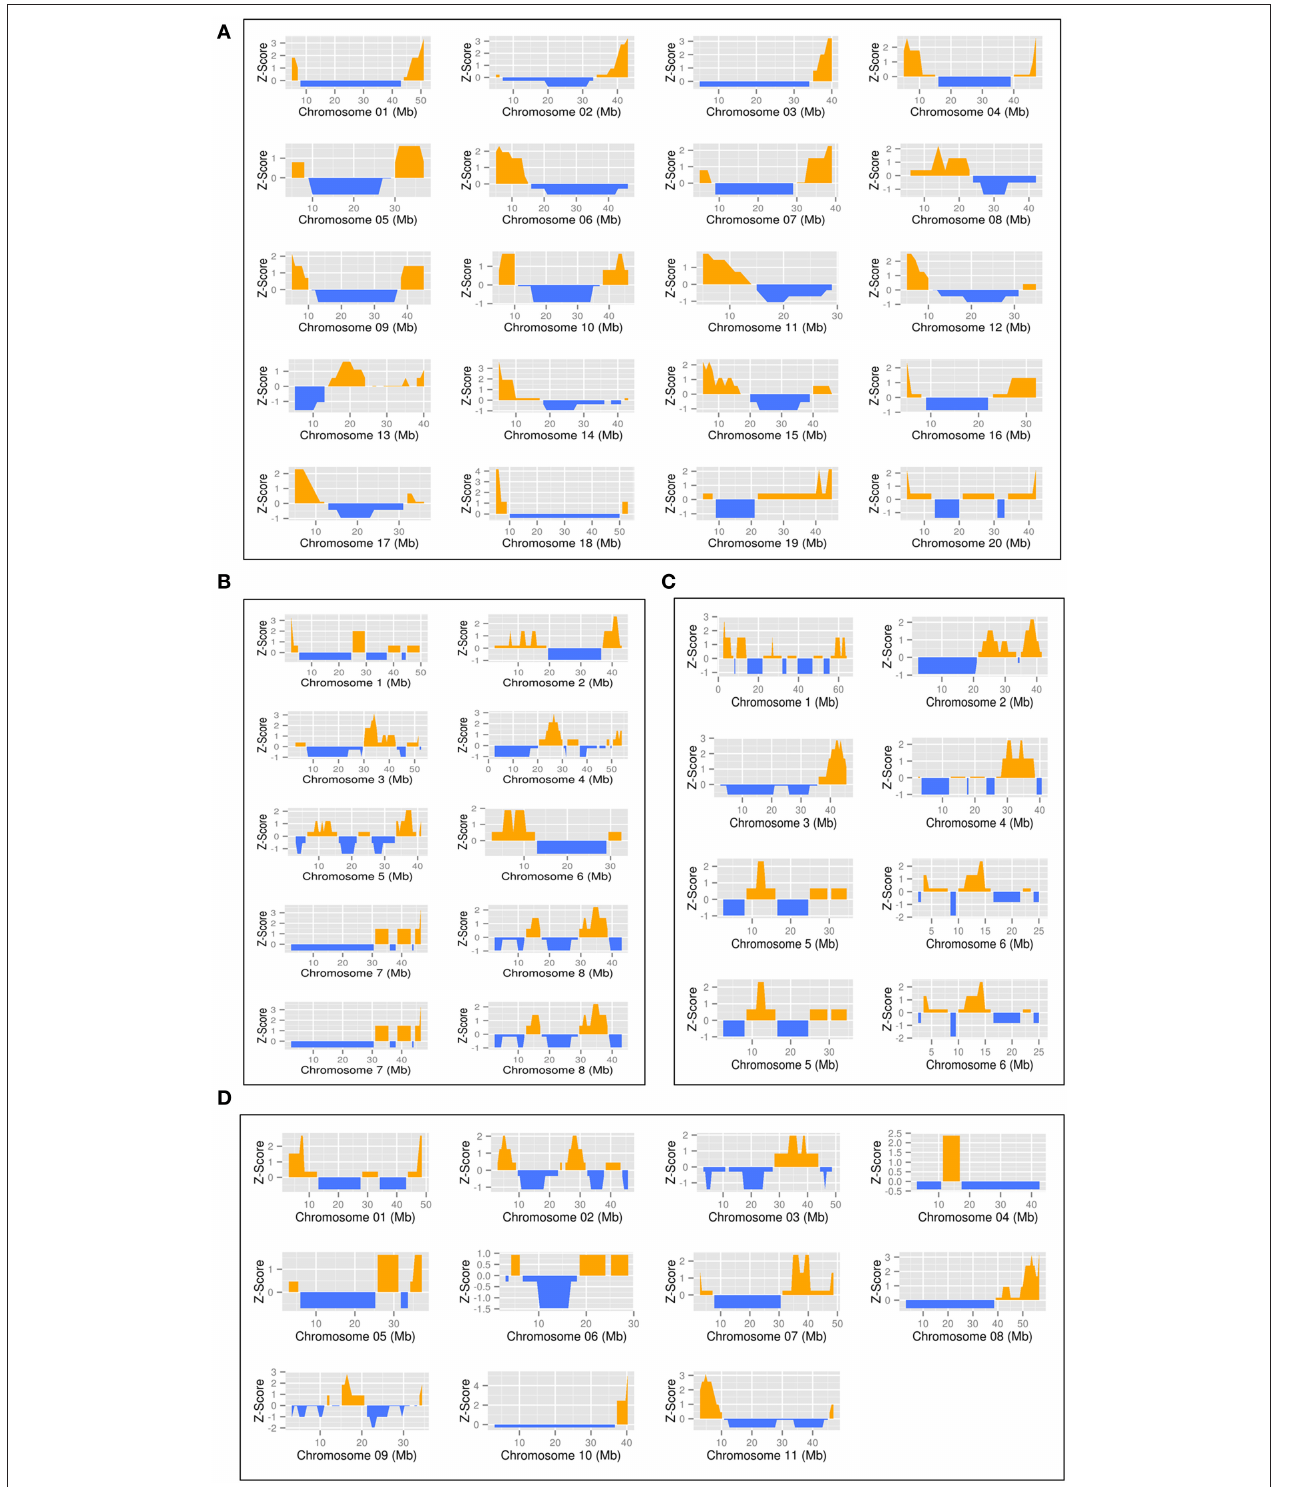
FIGURE 5 | Representation of the density of the legume nodulation genes along each legume chromosome. Gene density is represented by a z-score in a 10 Mb sliding window (step 1 Mb) along each chromosomes for each legume genome. Positive values are in orange, negative value in blue. The position on the chromosomes are indicated in Mb. The genomes represented are Glycine max (A) , Medicago truncatula (B) , Lotus japonicus (C) , and Phaseolus vulgaris (D) .